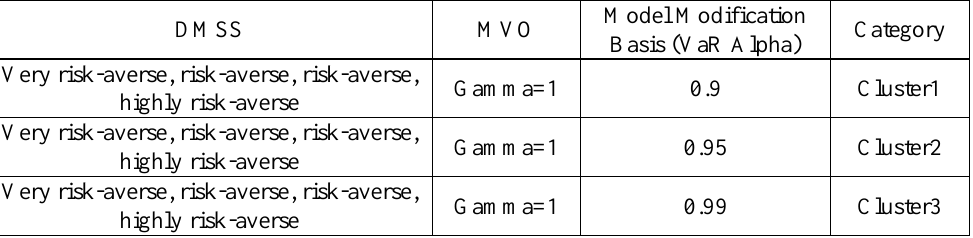
Table 4. (Research